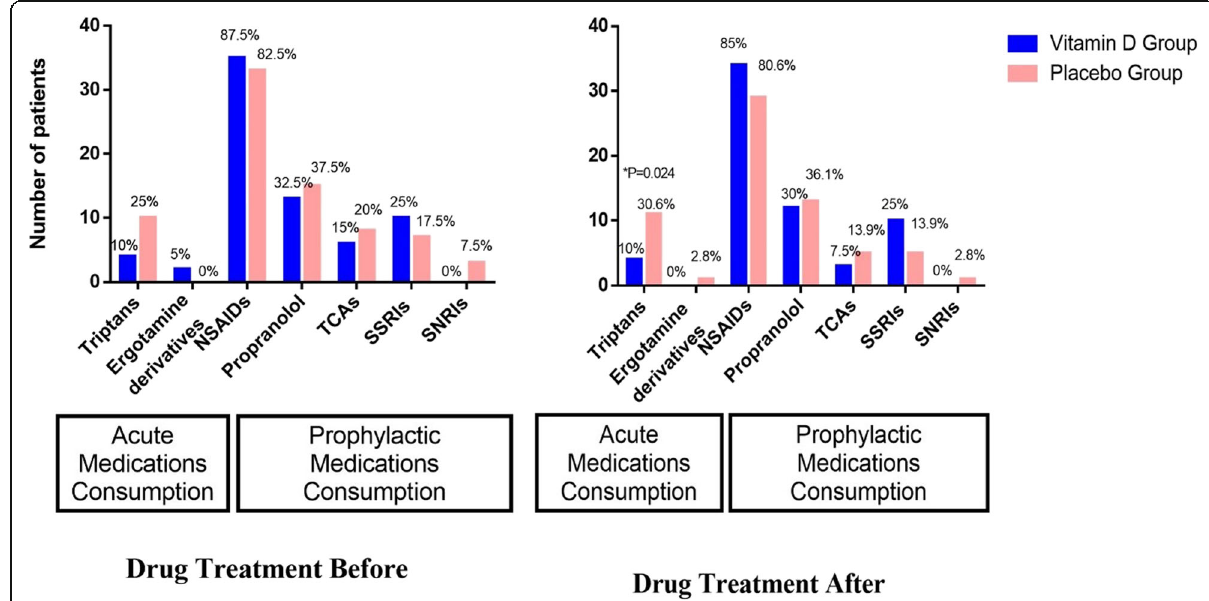
Fig. 2 Types of Medications Used By Studied Patients Throughout The Trial. NSAIDs, Nonsteroidal anti-inflammatory drugs. TCAs, Tricyclic antidepressants. SSRIs, Selective serotonin reuptake inhibitors. SNRIs, Serotonin-Norepinephrine Reuptake